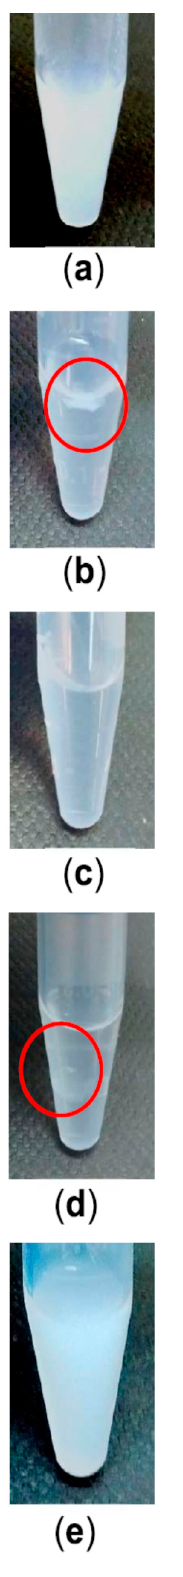
Figure 3. Checking solvent mixtures for the solubilization of lyophilized PMMA/PDDA A5 dispersion (1 mL) aiming at the preparation of coatings by spin-coating. Solvents were dichloromethane ( a ); 75% dichloromethane: 25% ethanol ( b ); 50% dichloromethane: 50% ethanol ( c ); 25% dichloromethane: 75% ethanol ( d ); and ethanol ( e ). The red circles emphasize the fact that some insoluble polymer still remained in the solvents mixture.